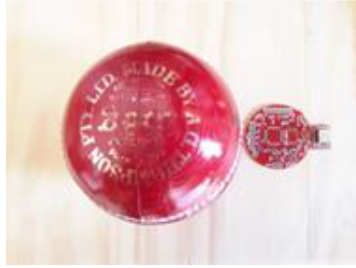
Figure 1. ( Left ) Smart cricket ball and its printed circuit board and sensor compound; ( right ) exploded view of the smart cricket ball